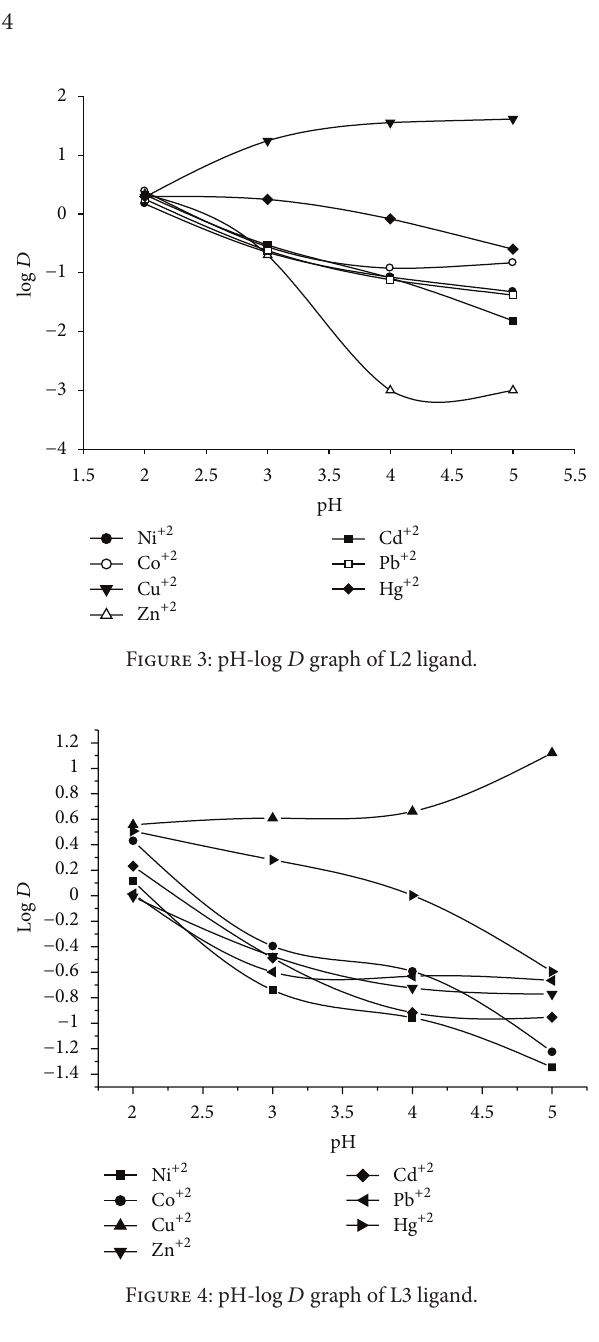
Figure 4: pH-log 𝐷 graph of L3 ligand.